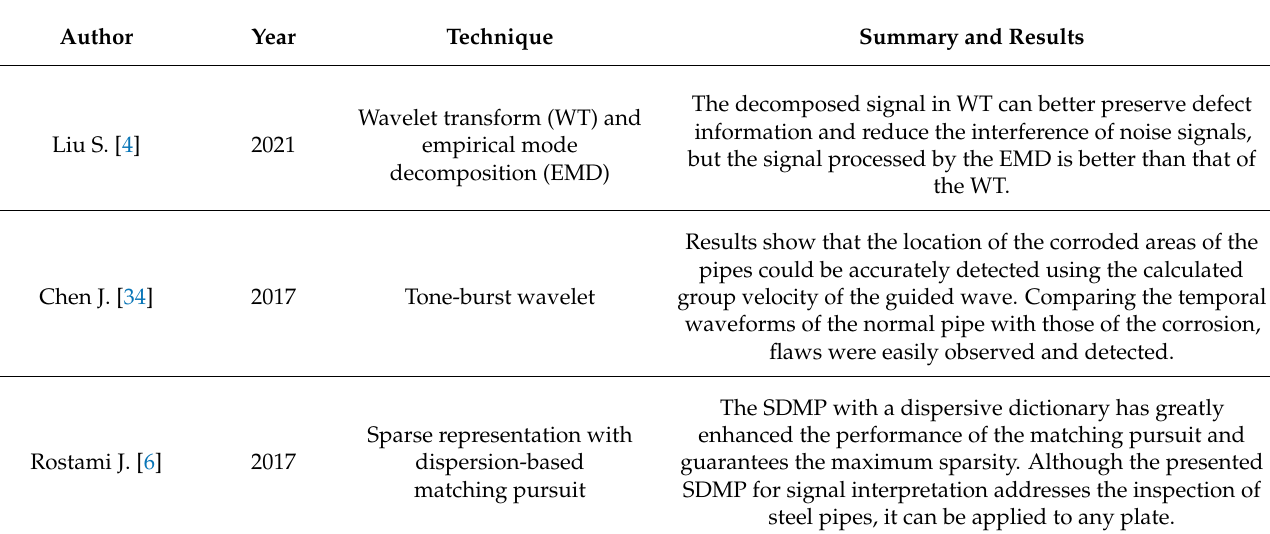
Table 2. Works found addressing signal processing techniques applied to